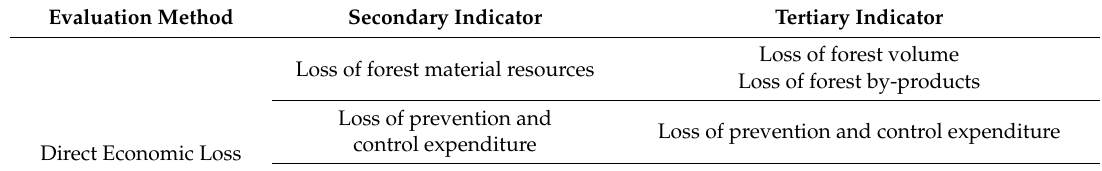
Table 1. Evaluation index system for economic loss of pine wood nematode